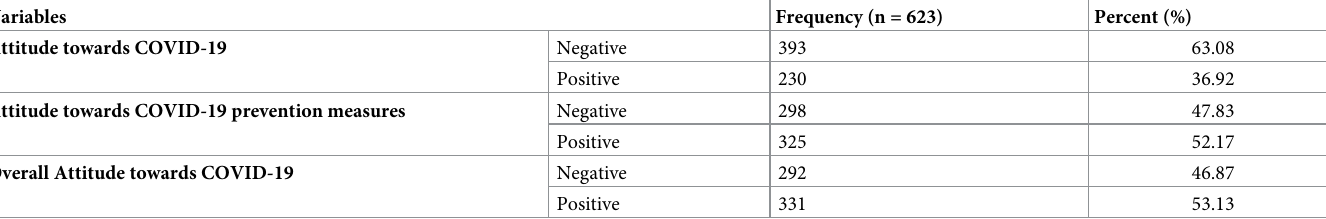
Table 3. Attitude of the study participants towards COVID-19 in Gondar city, northwest, Ethiopia, 2020.